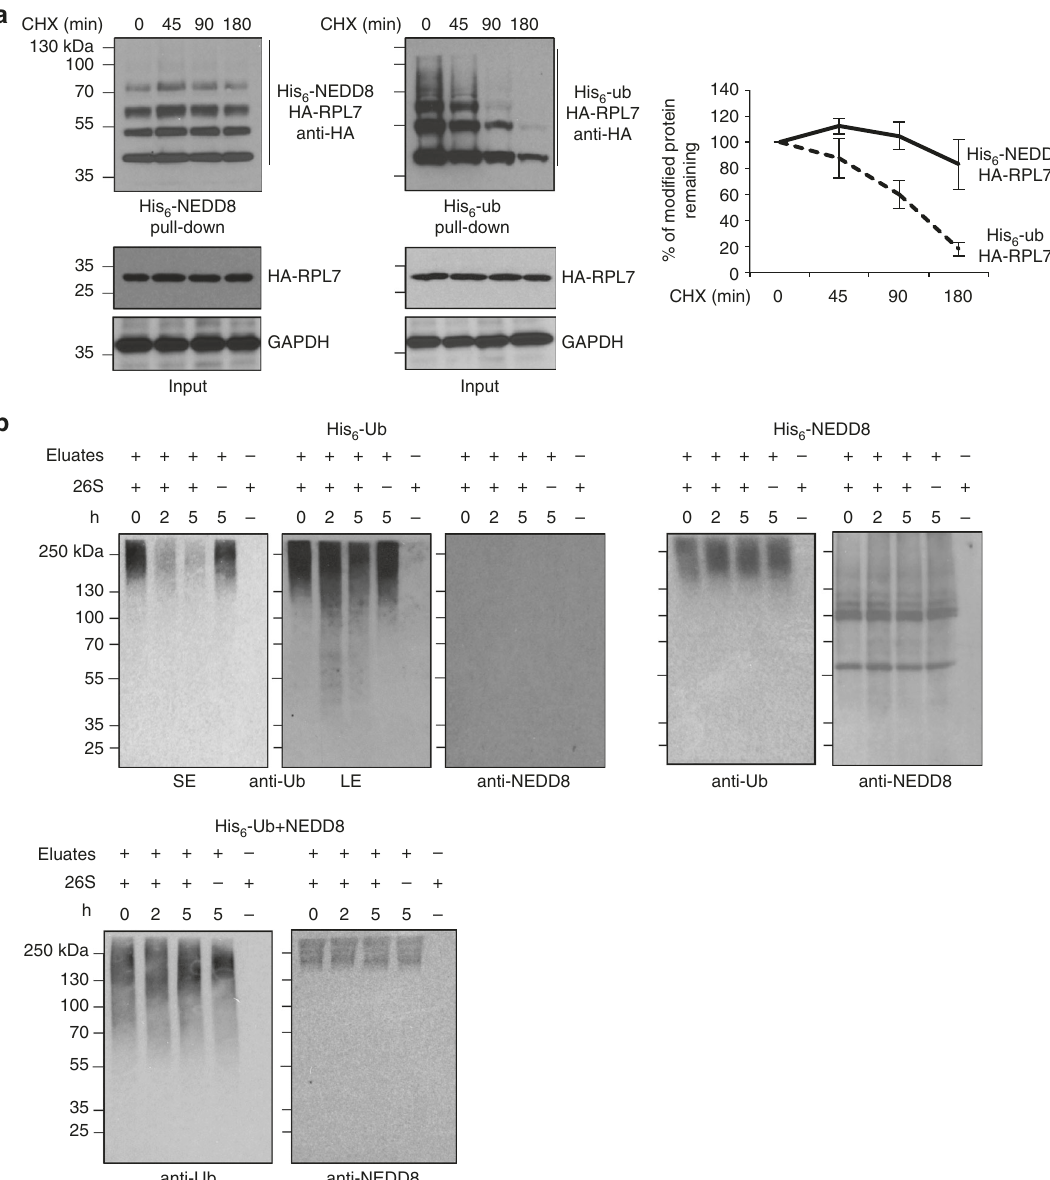
Fig. 9 NEDDylation compromises proteasomal degradation of substrates. a U2OS cells were transfected with 3 μ g of HA-RPL7 and 4 μ g of His 6 -NEDD8 or His 6 -ubiquitin. Forty-eight hours post-transfection cycloheximide (CHX, 100 μ g/ml) was added and cells were harvested at the indicated time points, before lysis and Ni-NTA pull-down. The signal in each lane within the length indicated by the bar was used for quanti fi cation. The graph represents the average values of three independent experiments ± SD. b His 6 -ubiquitin or His 6 -NEDD8 conjugates were isolated as described in Methods and used in vitro in a 26S proteasome processing/degradation assay. Western blotting was performed with the indicated antibodies (SE short exposure, LE long